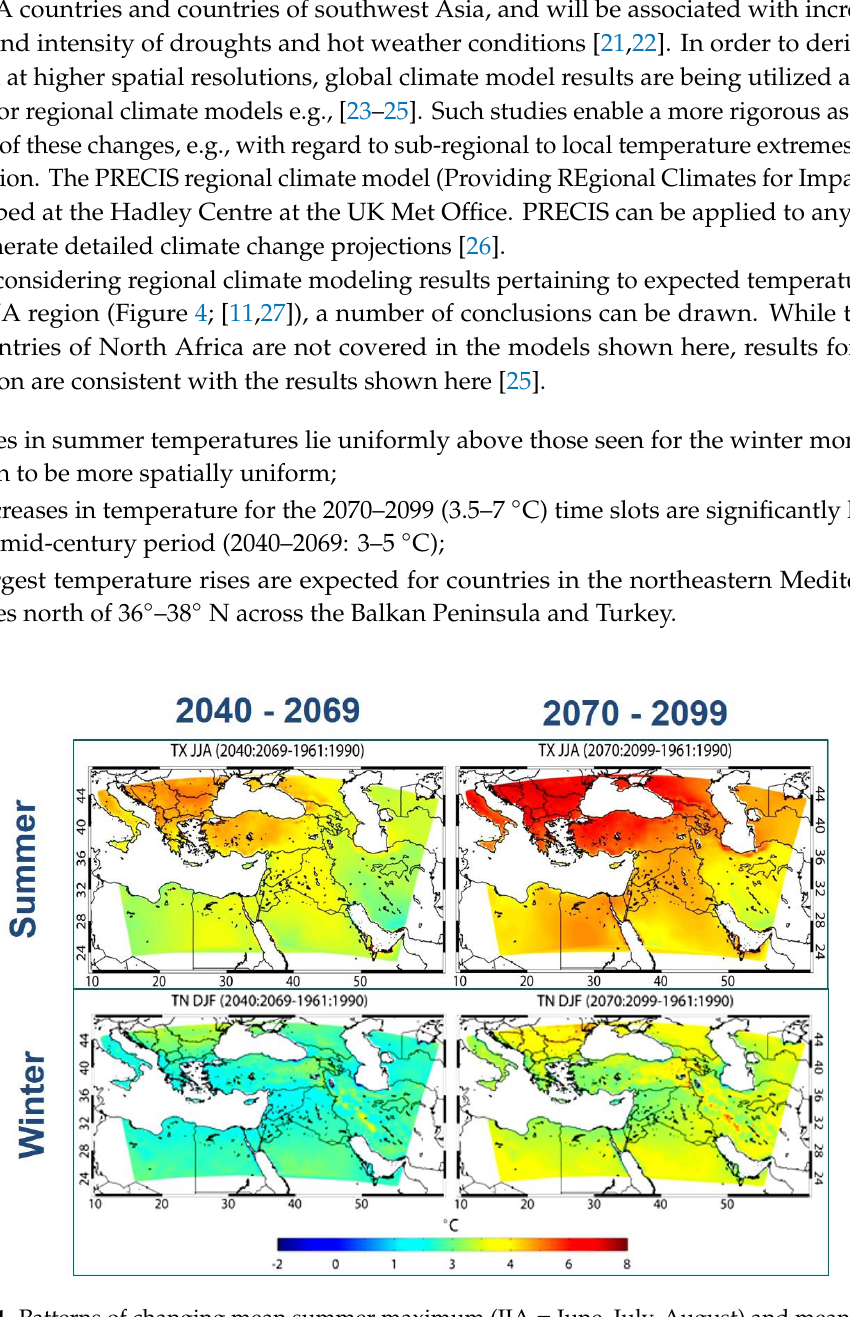
Figure 4. Patterns of changing mean summer maximum (JJA = June, July, August) and mean winter minimum (DJF = December, January, February) temperatures, TX (top) and TN (bottom), respectively, calculated from Providing REgional Climates for Impacts Studies (PRECIS) output. The left panels show projected mean changes in the temperature maximum (TX) and nighttime temperature minimum (TN) for 2040–2069 and the right panels for 2070–2099 relative to the 1961–1990 control period; modified after [11] .